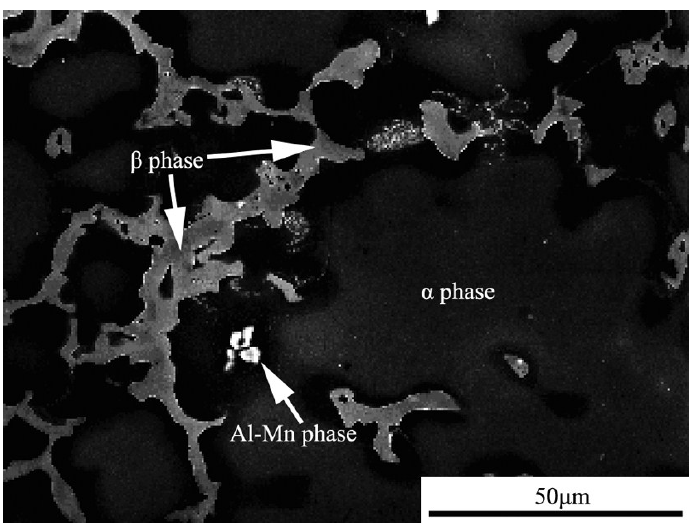
Figure 1. Microstructure of the AZ91D magnesium alloy.